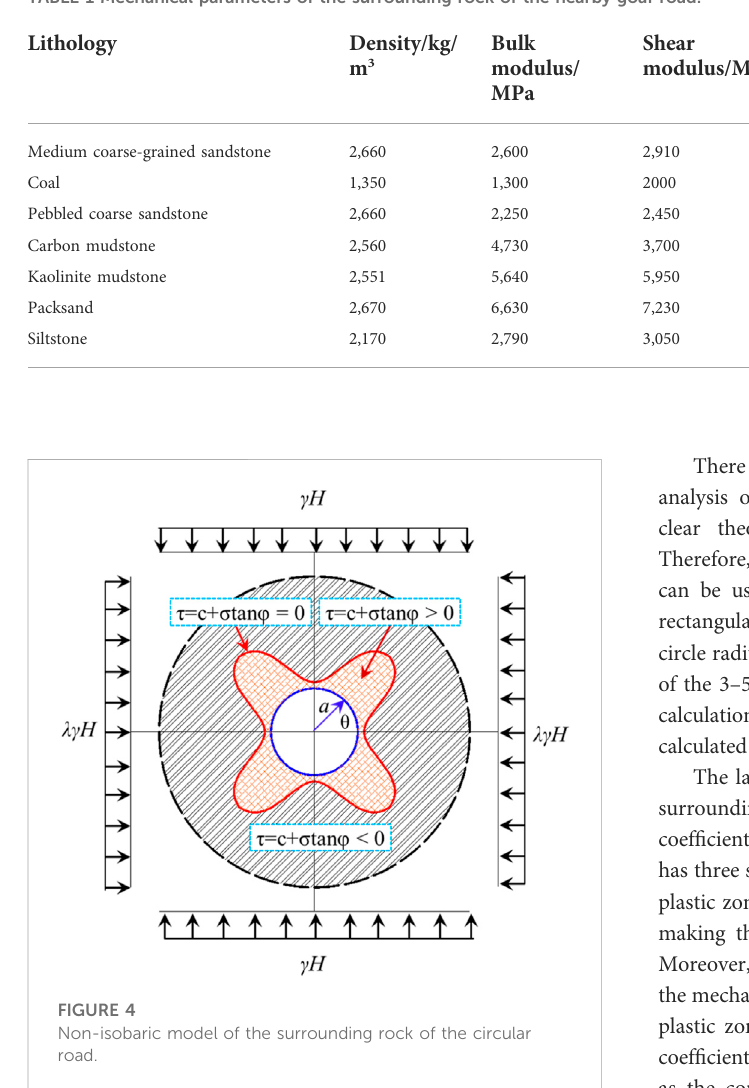
TABLE 1 Mechanical parameters of the surrounding rock of the nearby goaf road.